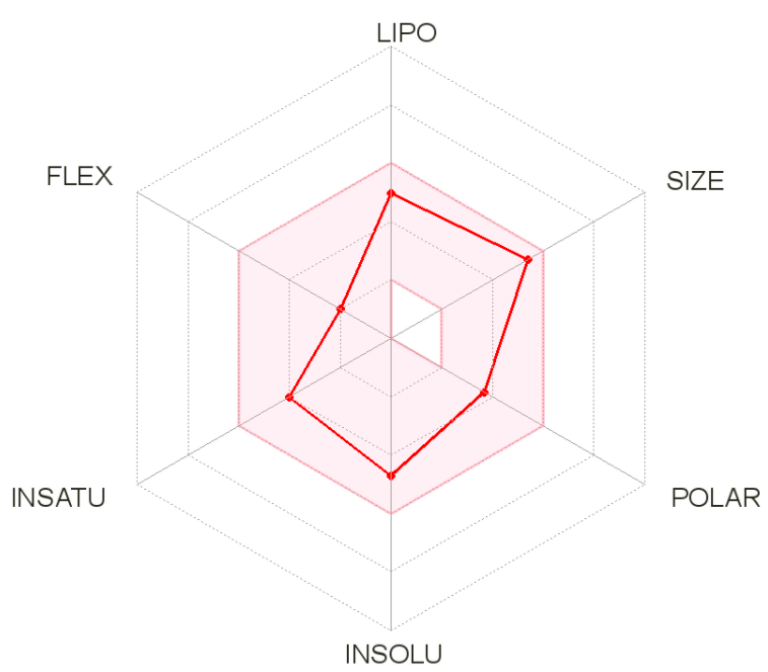
Figure 6. Oral bioavailability radar of the compound (shown by red line). The pink color zone repre-